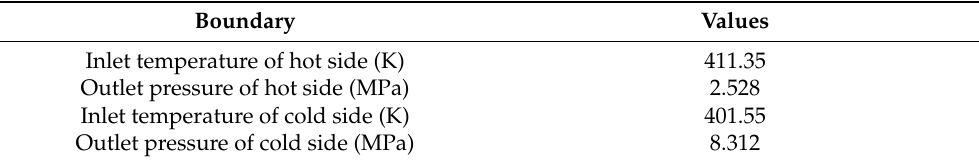
Table 1. Boundary condition.